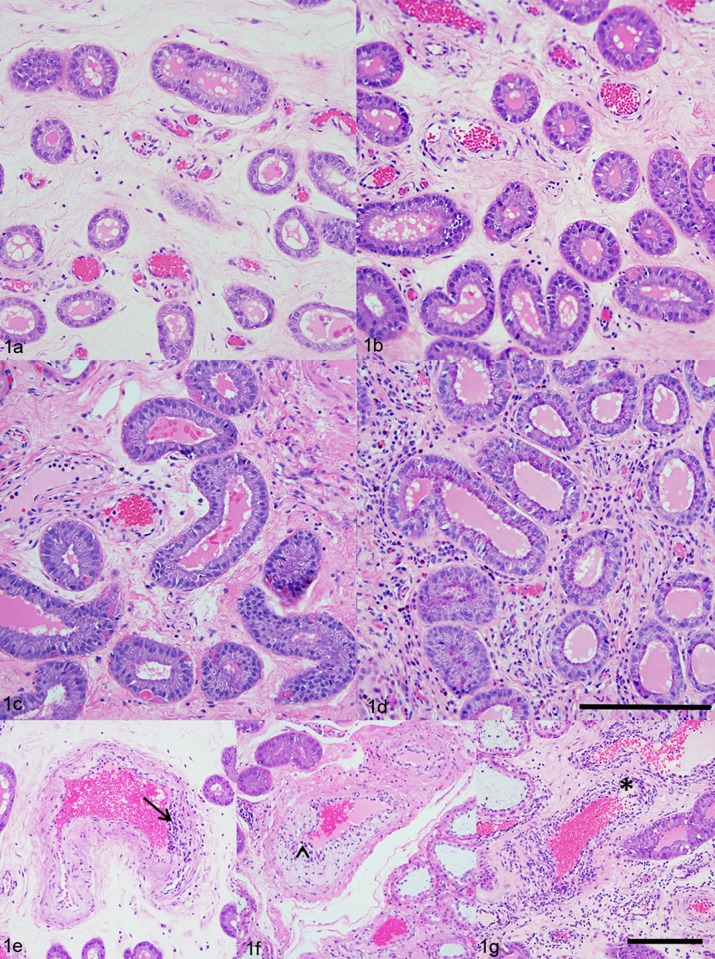
Histologic scores of endometrial inflammation and severity of vasculitis.(a) Uterus, endometrium, lamina propria; PRRSV-infected pregnant gilt; Hematoxylin and Eosin (HE). Minimal lymphohistiocytic endometritis (grade 1.). (b) Uterus, endometrium, lamina propria; PRRSV-infected pregnant gilt; HE. Mild lymphohistiocytic endometritis (grade 2.). (c) Uterus, endometrium, lamina propria; PRRSV-infected pregnant gilt; HE. Moderate lymphohistiocytic endometritis (grade 3.). (d) Uterus, endometrium, lamina propria; PRRSV-infected pregnant gilt; HE. Severe lymphohistiocytic endometritis (grade 4.) (Scale bar = 200 μm). (e) Uterus, endometrium, blood vessel; PRRSV-infected pregnant gilt; HE. Lymphocytic vasculitis (severity grade 1.) (arrow). (f) Uterus, endometrium, blood vessel; PRRSV-infected pregnant gilt; HE. Lymphocytic vasculitis with vacuolar degeneration of the cells in the tunica intima (severity grade 2.) (arrowhead). (g) Uterus, endometrium, blood vessel; PRRSV-infected pregnant gilt; HE. Severe lymphocytic vasculitis with necrosis (severity grade 3.) (asterisk) (Scale bar = 200 μm).